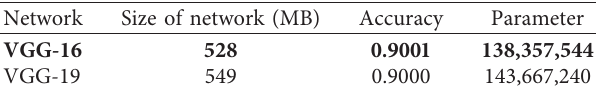
Table 1: Evaluating parameters of CNN based on ImageNet dataset from Keras